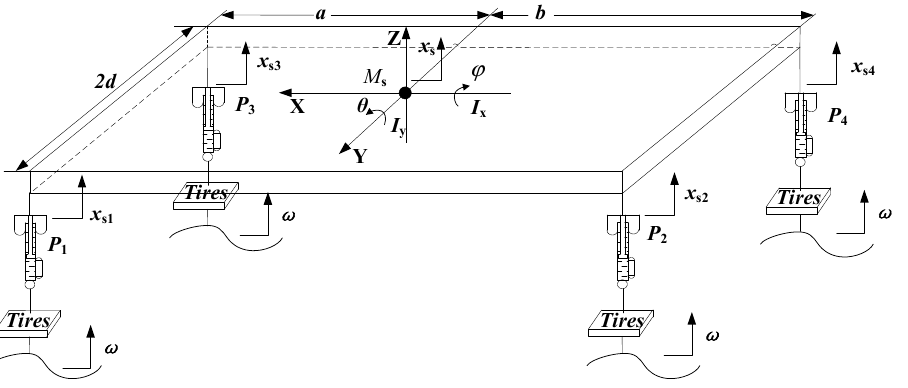
Figure 2. Dynamic model of the whole vehicle based on ECAS.